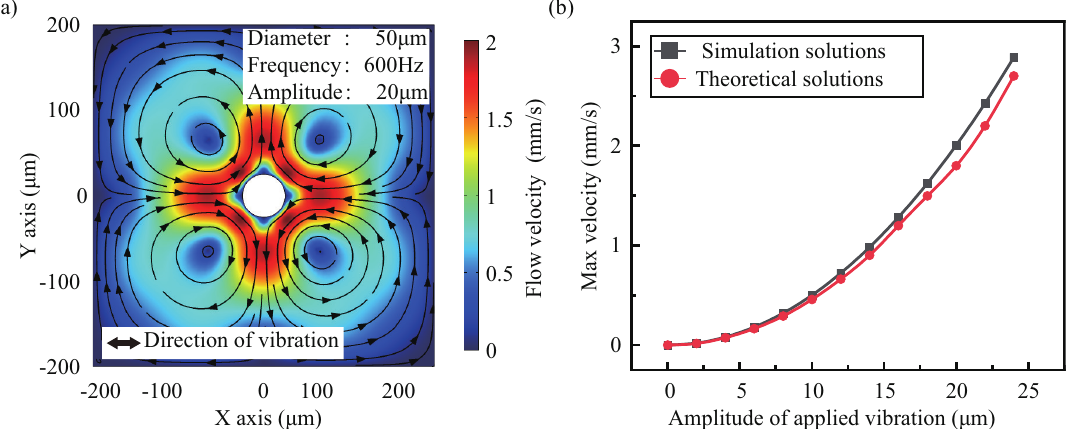
Figure A2. Numerical simulation VS Theoretical calculation. ( a ) Two − dimensional distribution of the flow velocity obtained by simulation. ( b ) Maximum velocity of simulation and theoretical solutions under different vibration amplitudes. The red line and black line represent theoretical solutions and simulation solutions